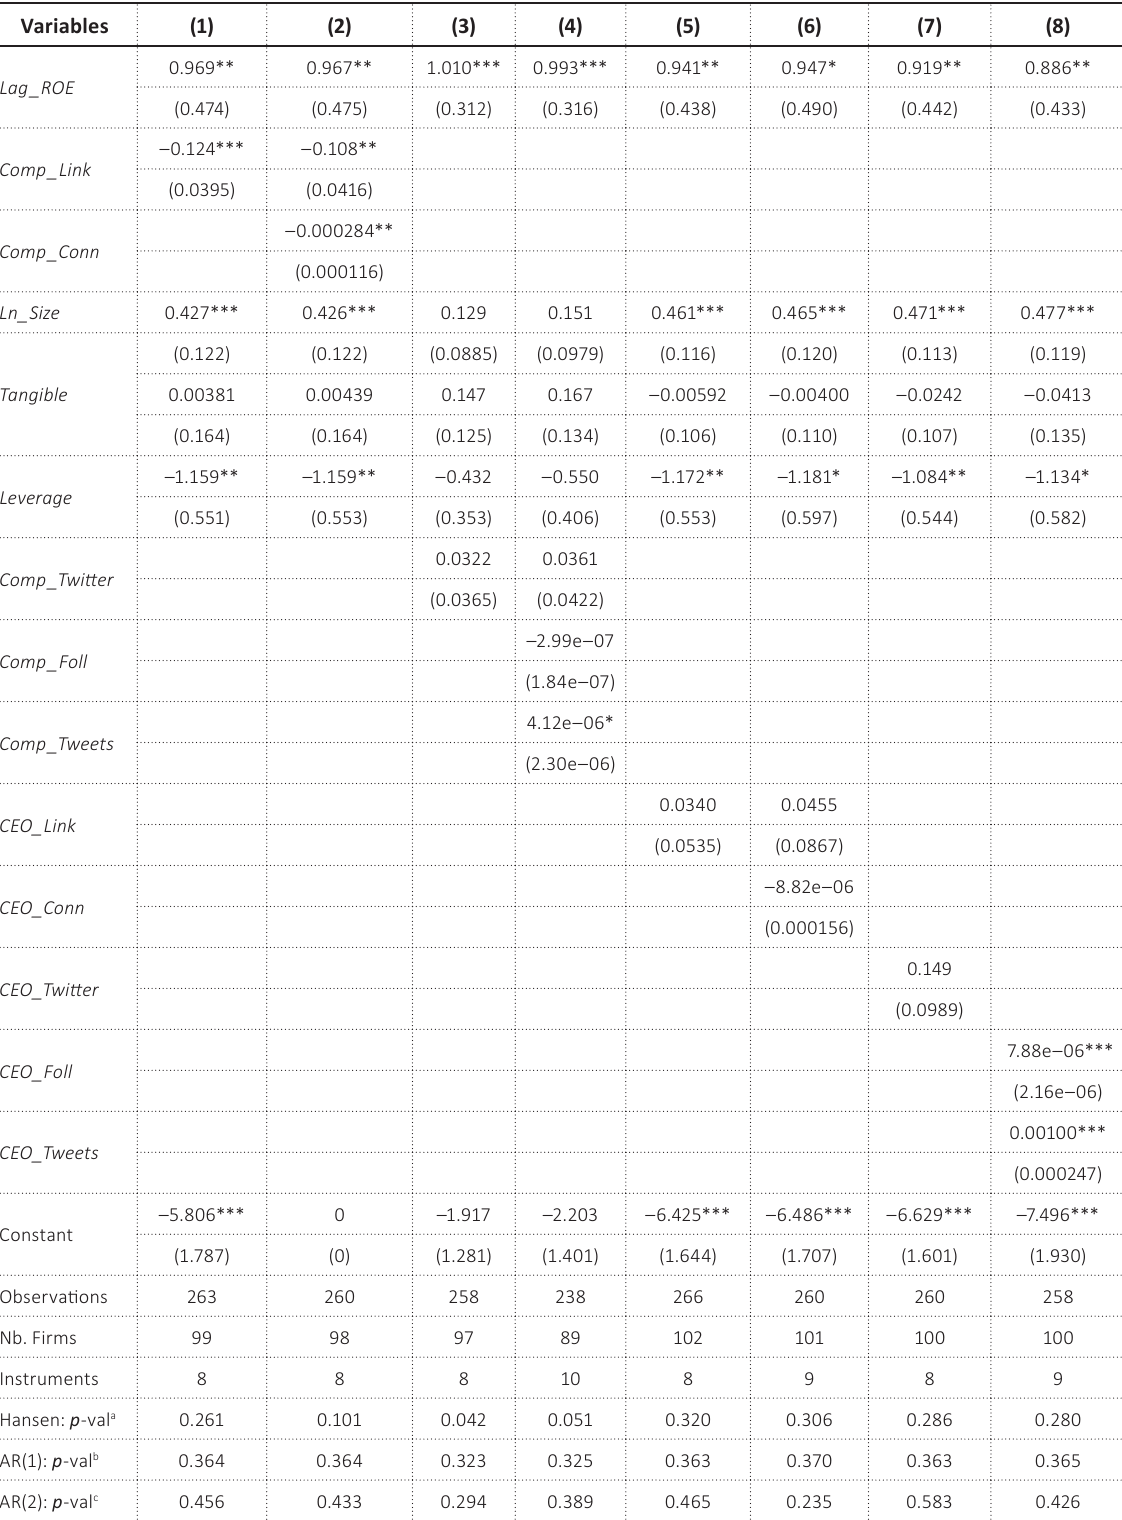
Table 6. Estimation results using the ROE performance